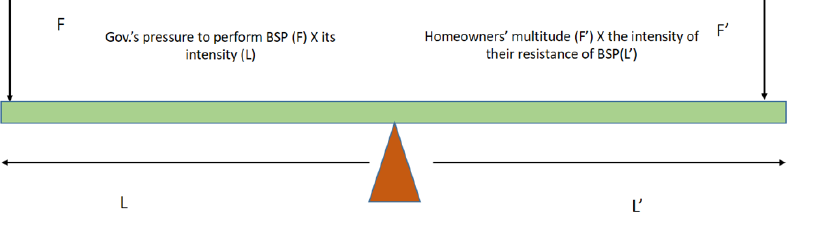
Fig. 6. Torque frameworks of BSP (developed by the